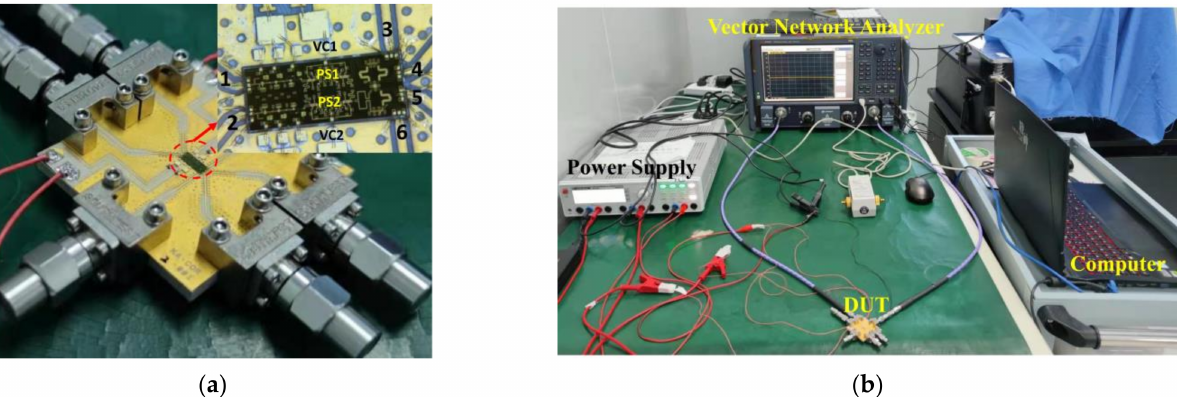
Figure 18. The photograph of the fabricated chip and test platform: ( a ) The microphotograph of the fabricated integrated six-port chip and test fixture; ( b ) The photograph of the automatic test platform for the integrated six-port